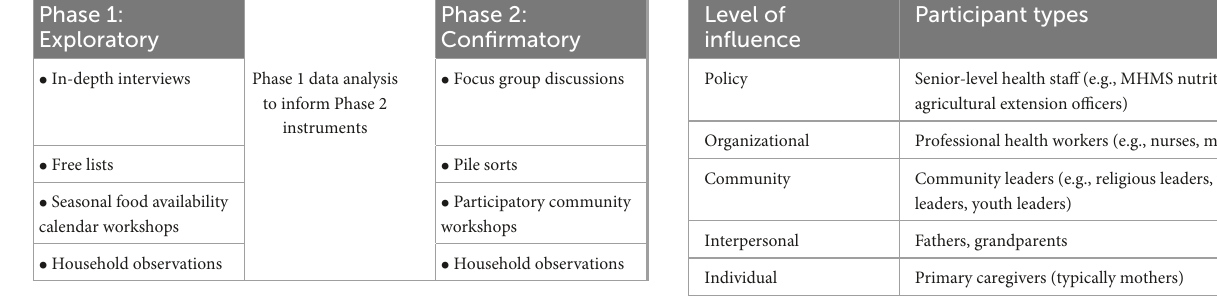
TABLE 1 Study design with data collection methods by study phase. Phase 1: Exploratory